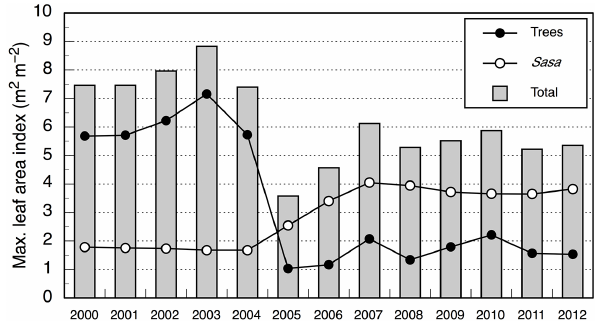
Figure 6. Interannual changes in carbon stock in dwarf bamboo ( Sasa kurilensis and S. senanensis ). Sasa biomass is estimated from the light transmittance.